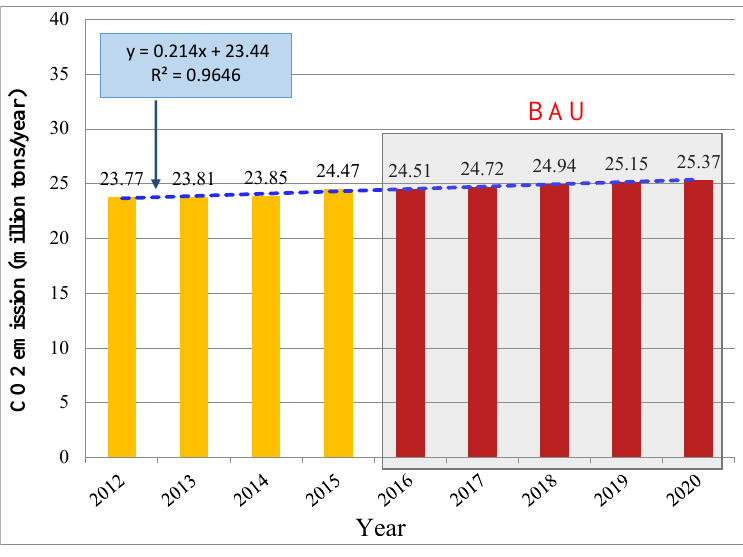
Figure 9. The business-as-usual level of CO 2 emissions from 2016 to 2020.